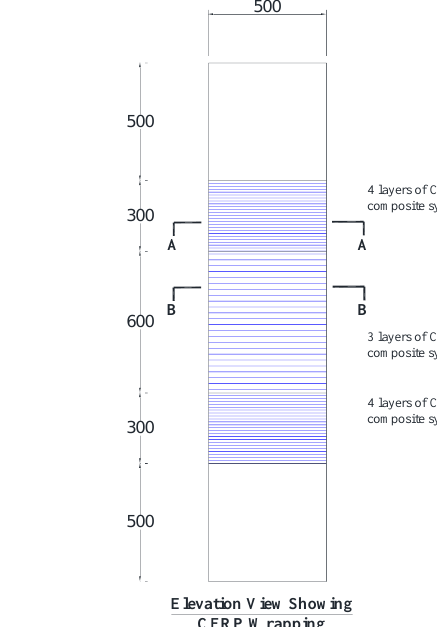
Figure 2. Dimensions and reinforcement detailing of strengthened specimen SW1 (note: all dimen- sions are in mm).